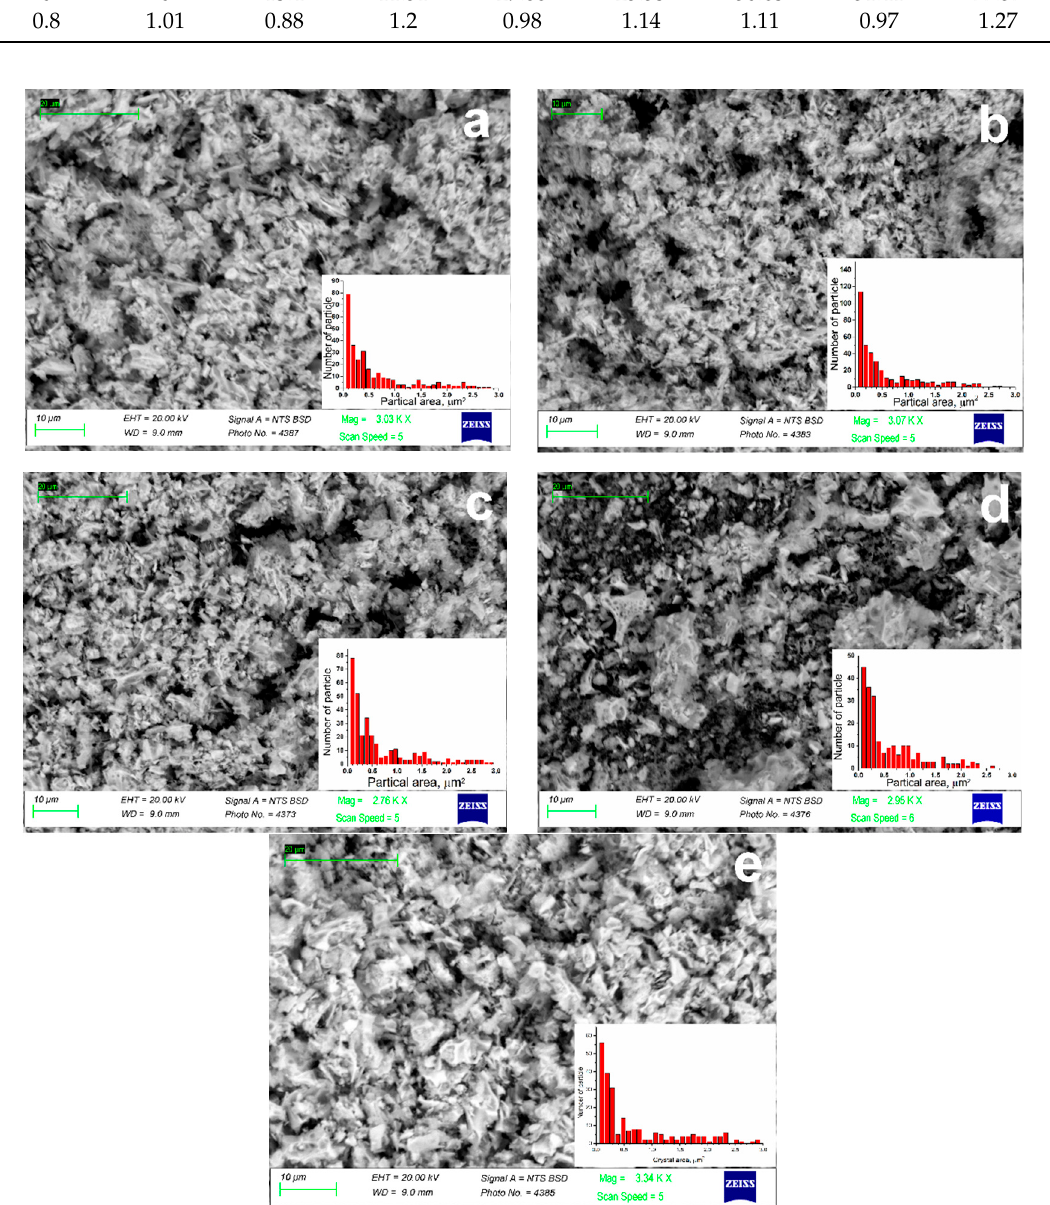
Figure 3. SEM images of (Gd 1 − x Y x ) 2 O 3 powders, where x = ( a ) 0; ( b ) 0.25; ( c ) 0.5; ( d ) 0.75; ( e ) 1.